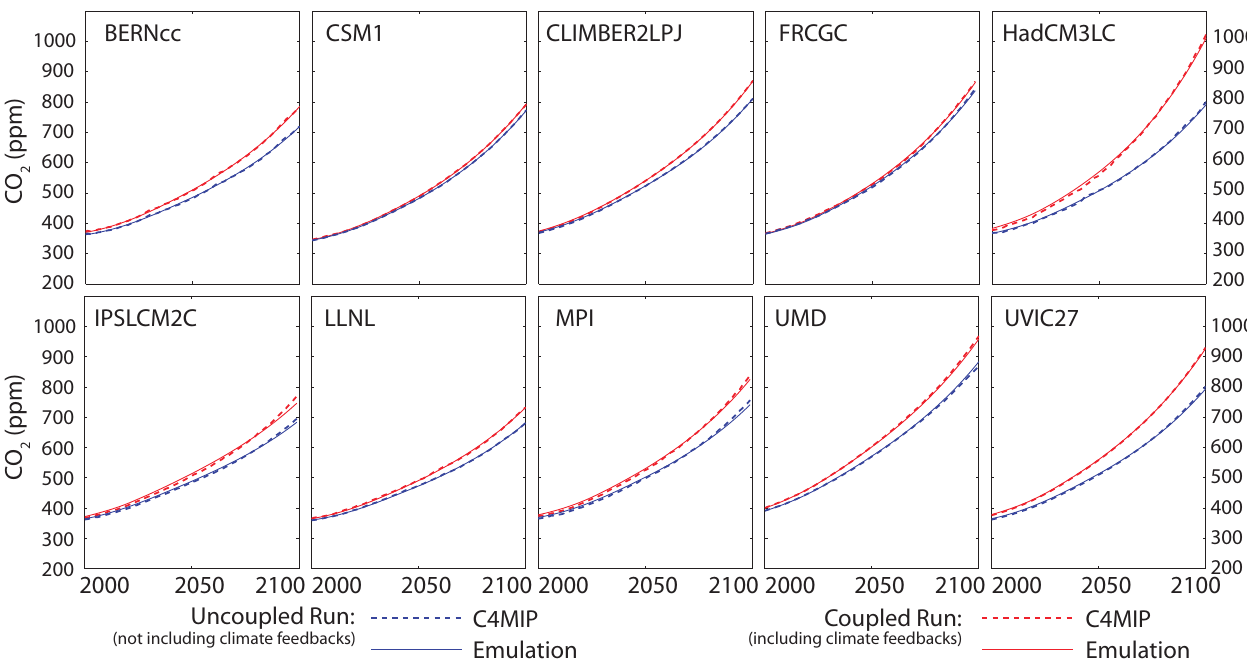
Fig. 6. Atmospheric CO 2 concentrations from 2000 to 2100 comparing C 4 MIP carbon cycle model results (dashed) with the calibrated MAGICC6 (solid) model. Shown are the coupled (including climate feedbacks, red lines) and uncoupled (excluding climate feedbacks, blue lines) runs for the anthropogenic CO 2 emissions based on the IPCC SRES A2 scenario. See Fig. B4 in Appendix B for comparisons between emulations and C 4 MIP models of other carbon fluxes and